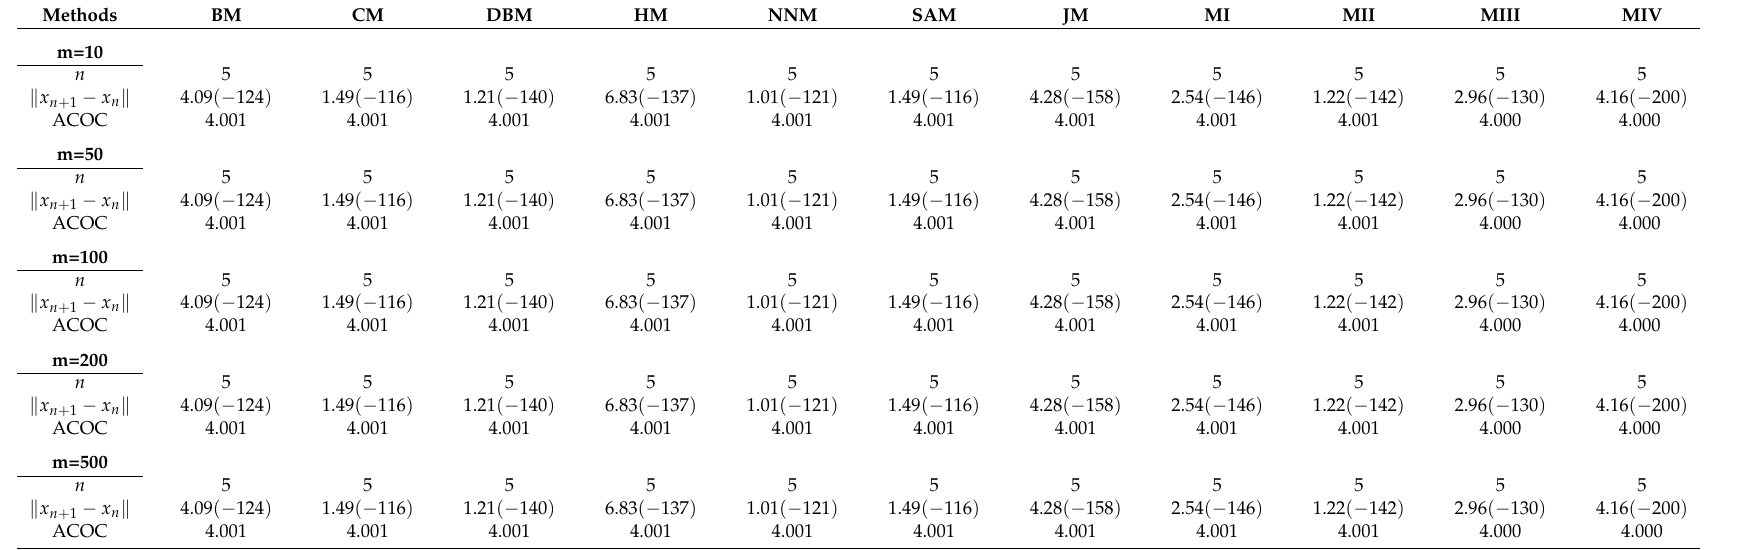
Table 4. Comparison of performance of methods for Problem